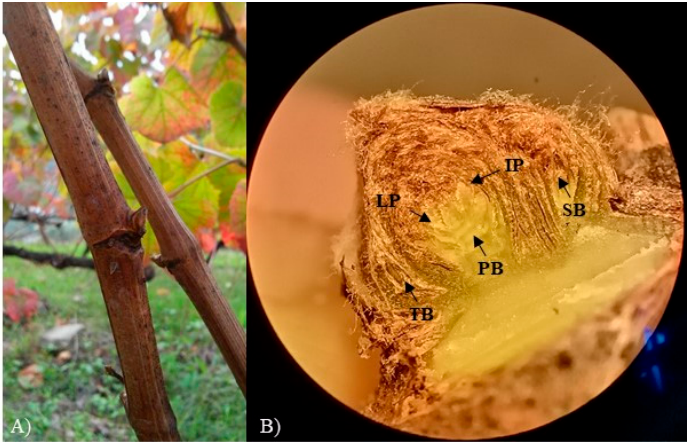
Figure 2. ( A ) Bud of Fernão-Pires variety during the dormant period surrounded in set of bracts that protects them from unfavorable environmental conditions, pests, and diseases. ( B ) Longitudinal section of a dormant bud of Loureiro variety obtained by dissection, showing bud position: in a central position the primary bud (PB) and the secondary (SB) and tertiary bud (TB) on each of primary bud. LP-Leaf primordia, IP-Inflorescence primordia.